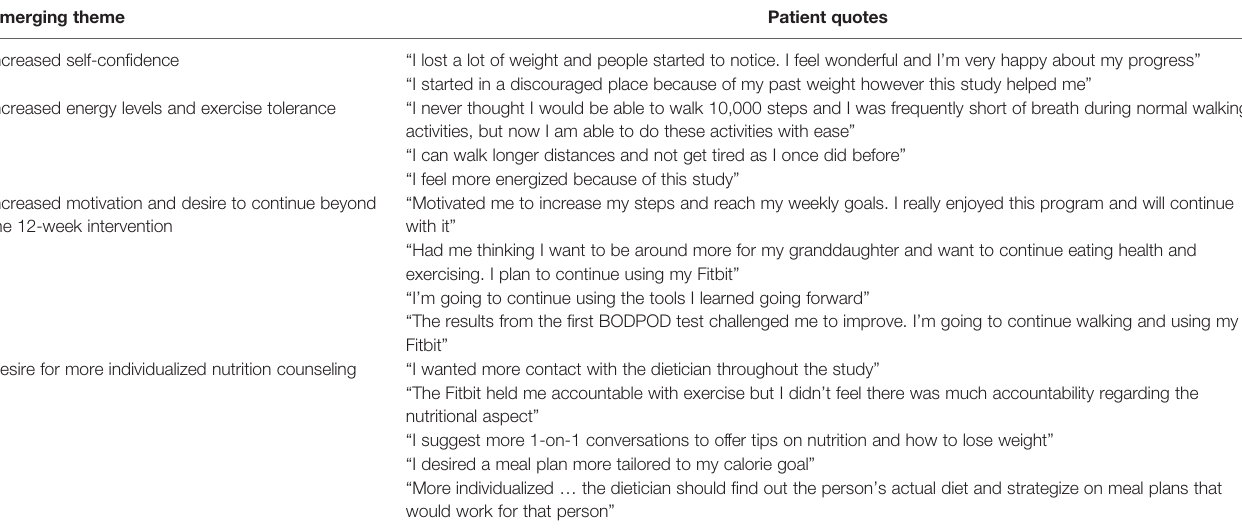
TABLE 4 | Free responses to qualitative prompts and corresponding themes. Emerging